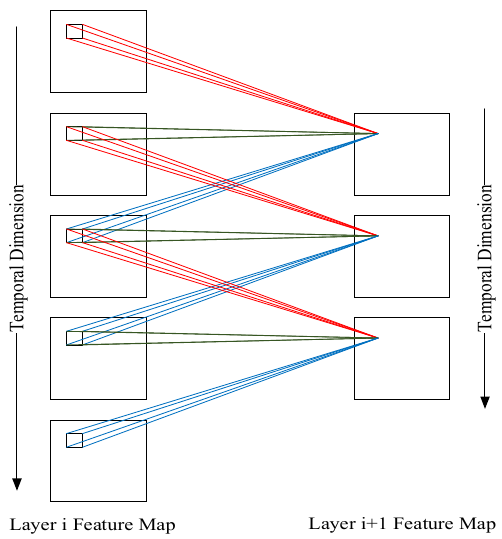
Figure 3. Illustration of 3D convolution to extract spatiotemporal features.